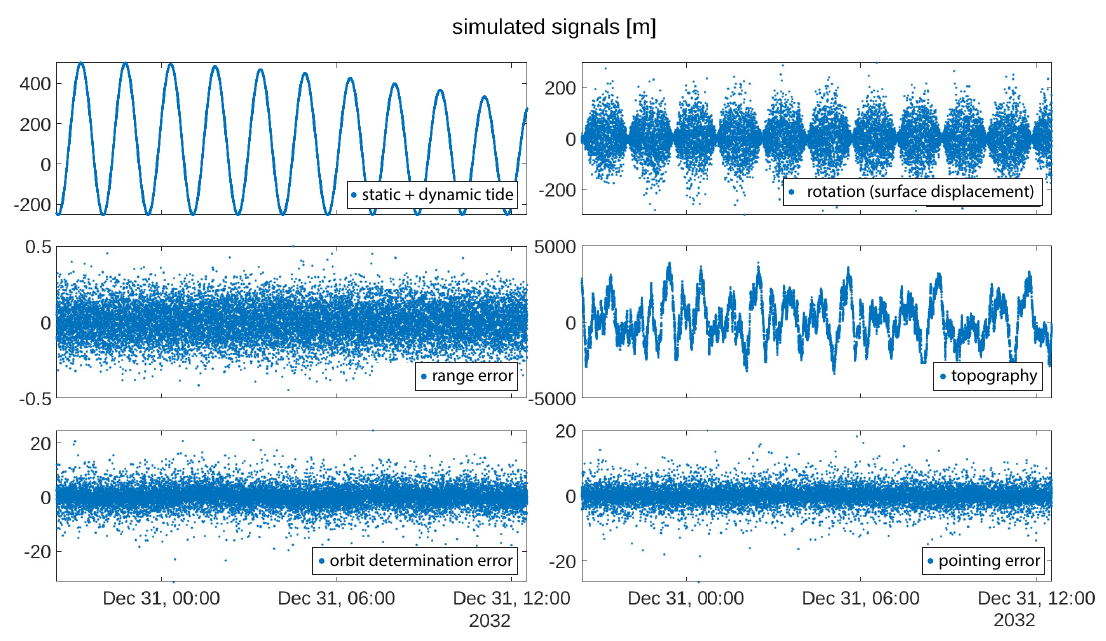
Figure 3. Simulated signals as observed by GALA over a time frame of 16 h. The tidal signal contains the static tide. Tidal and rotational signals are dominated by their latitude dependence. The pointing error and the lateral components of the orbit error contribute to the measurements through the topography, which was synthetically generated to degree L = 7999 for this plot. The ground-track has been sampled with 3